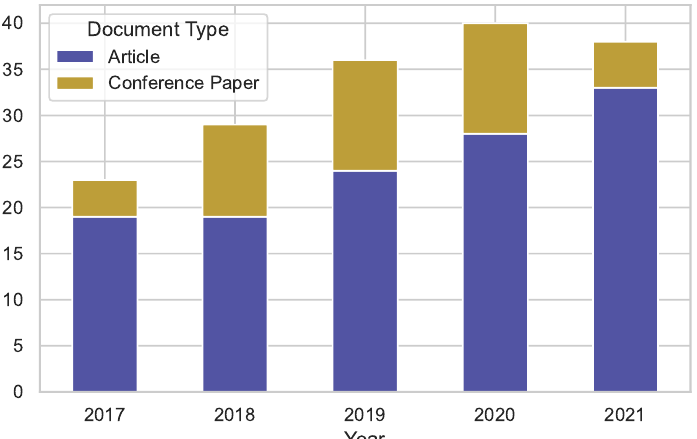
Figure 3. Evolution of investigated papers by document